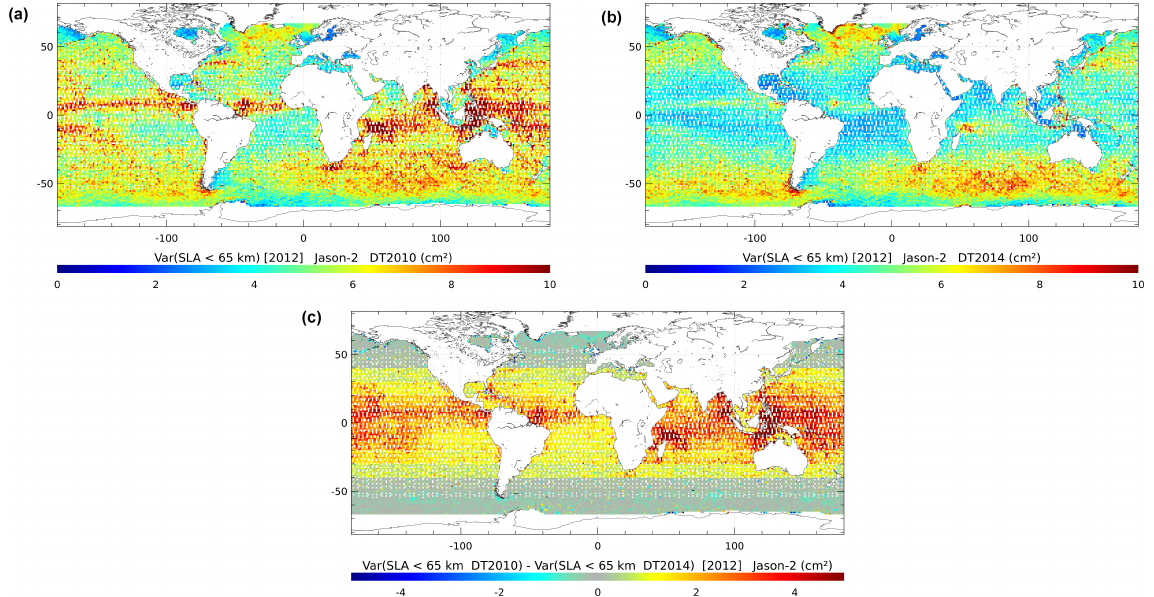
Figure 6. Variance of the short-wavelength signal removed (by low-pass filtering) on L3 along-track J2 SLA in the DT2010 (a) and DT2014 (b) versions. (c) Difference between (a) and (b) . Statistics done over year 2012.